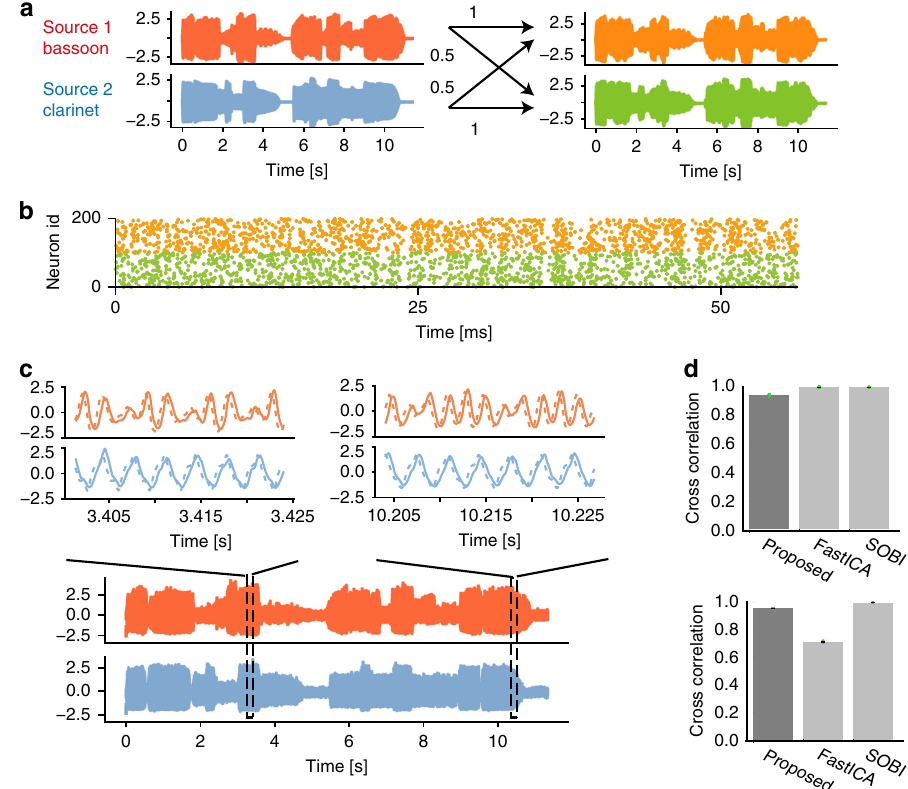
Fig. 7 BSS of correlated auditory streams. a Sound waveforms of a bassoon and a clarinet (left) were linearly transformed to two mixed signals (right). The diagonal and off-diagonal elements of the mixing matrix were 1 and 0.5, respectively. b Nonstationary Poisson spike trains of 200 input neurons (from a total of 500) are shown. The instantaneous fi ring rates were proportional to the amplitudes of the mixed signals normalized between 0 Hz and 10 Hz. Each input neuron encodes only one of the two mixed signals. c Separated waveforms (bottom) are shown together with magni fi ed versions (top, solid) and true sources (top, dashed). The waveforms were averaged over 20 trials with different realizations of input spike trains and the same initial weights. For the clarity of presentation, error bars are not shown. d Cross-correlations between the separated and true sources are compared between our model, FastICA and SOBI for independent (top) and dependent (bottom) auditory signals (see Methods). For each comparison, n = 20 independent simulations were performed. Error bars show s.d.s, which were very small. Overlaid green circles are data